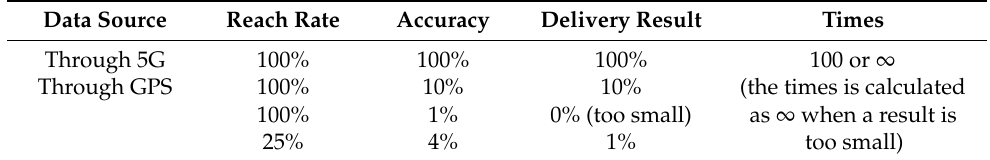
Table 21. Comparison of delivery effectiveness on commuters traveling between specific two places. Data